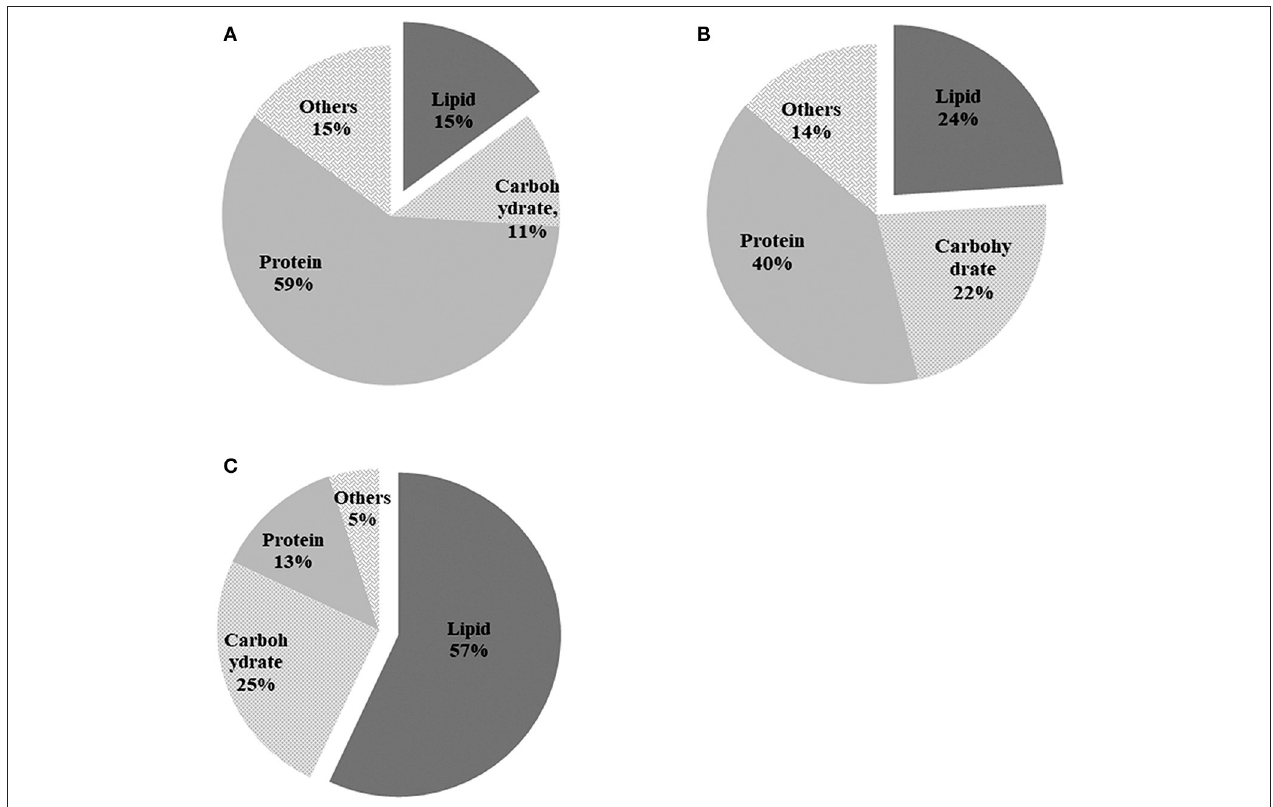
FIGURE 6 | Biochemical composition of pure algae in (A) TAP medium before incubation in the nitrogen-deprived medium; (B) pure algae; and (C) algae in the co-culture after 9 d of incubation in the TAP-N medium. Pure algae in the TAP medium and pure algae incubated for 9 d in the TAP-N medium were used as controls . Light intensity was 200 µ E · m − 2 · s − 1 and the volume ratio of bacteria (OD 600 = 1.0) and (OD 750 = 1.0) was 1:40. All the data are the means of three independent experiments with triplicates performed for each